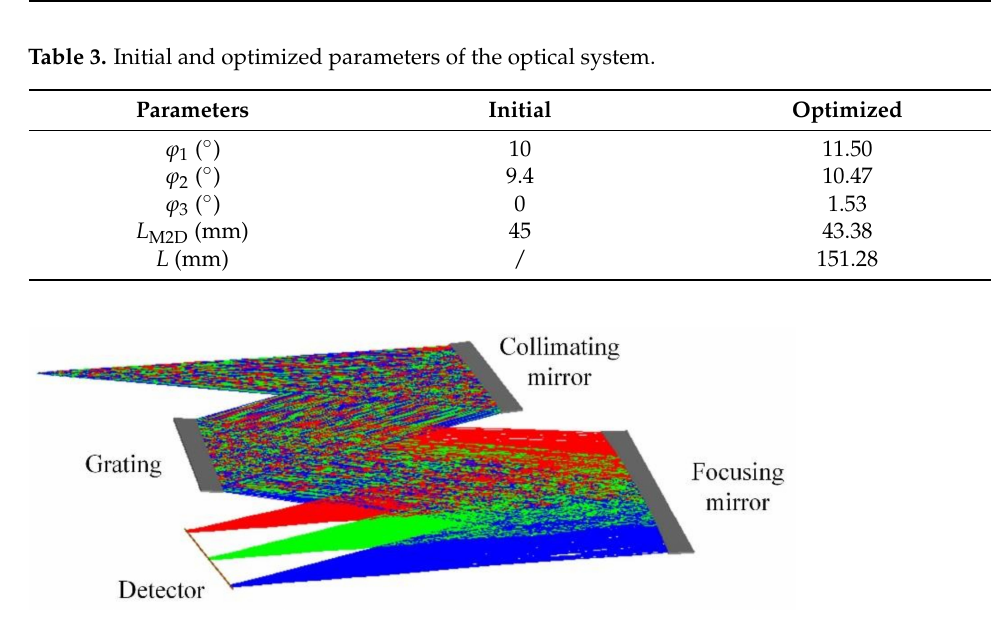
Figure 2. Simulation model of the HPWS.